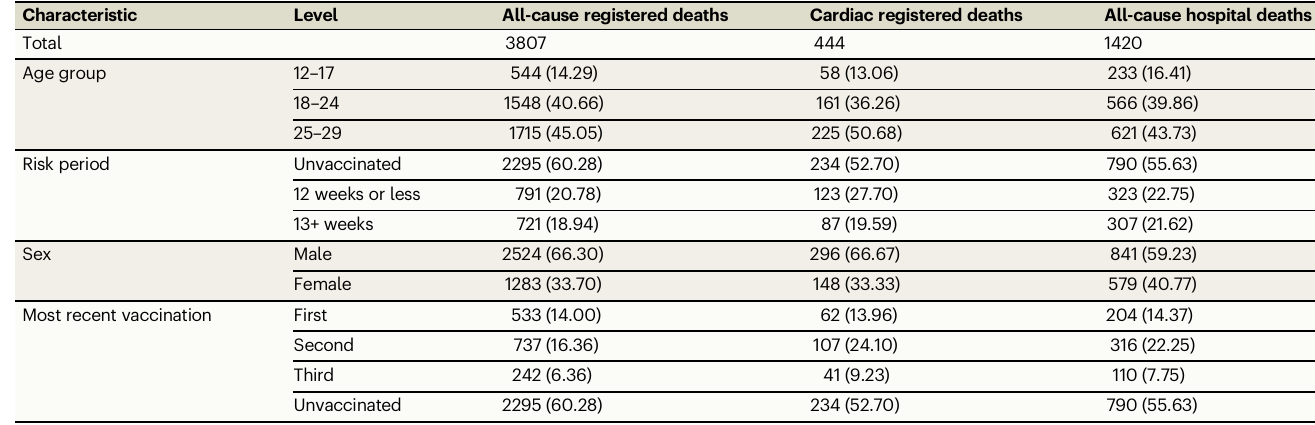
Table 1 | Characteristics of the study population for deaths after vaccination, young people aged 12-29, resident in England, who died between 8 December 2020 − 25 May 2022 (registered by 8 June 2022) for ONS registered deaths, and who died